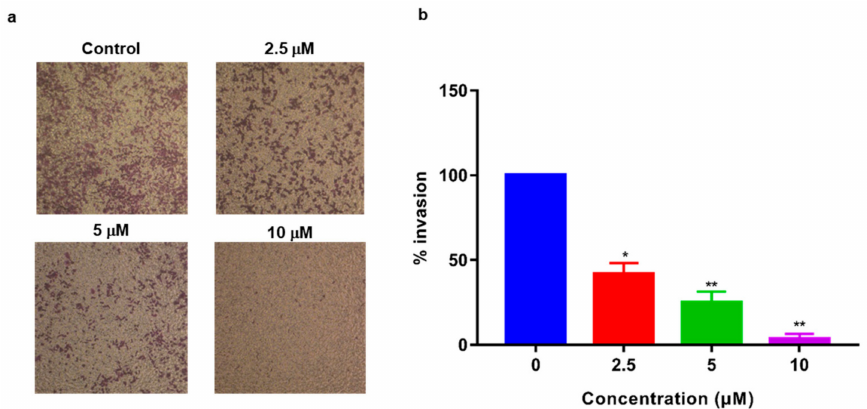
Figure 4. ( a ) MDA-MB-231 cell invasion was a ff ected after culturing with TSC-3C at various concentrations (100 × ). ( b ) Histogram of the inhibition rate of TSC-3C in MDA-MB-231 cell invasion. The data are expressed as the means ± SD from three independent experiments. * p < 0.05 vs. the control group, ** p < 0.01 vs. the control